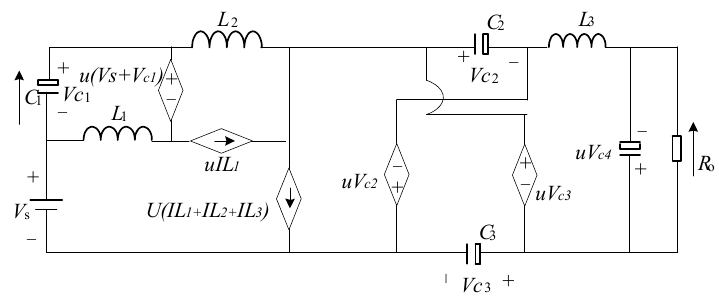
Figure 7. Average equivalent circuit of the proposed converter.